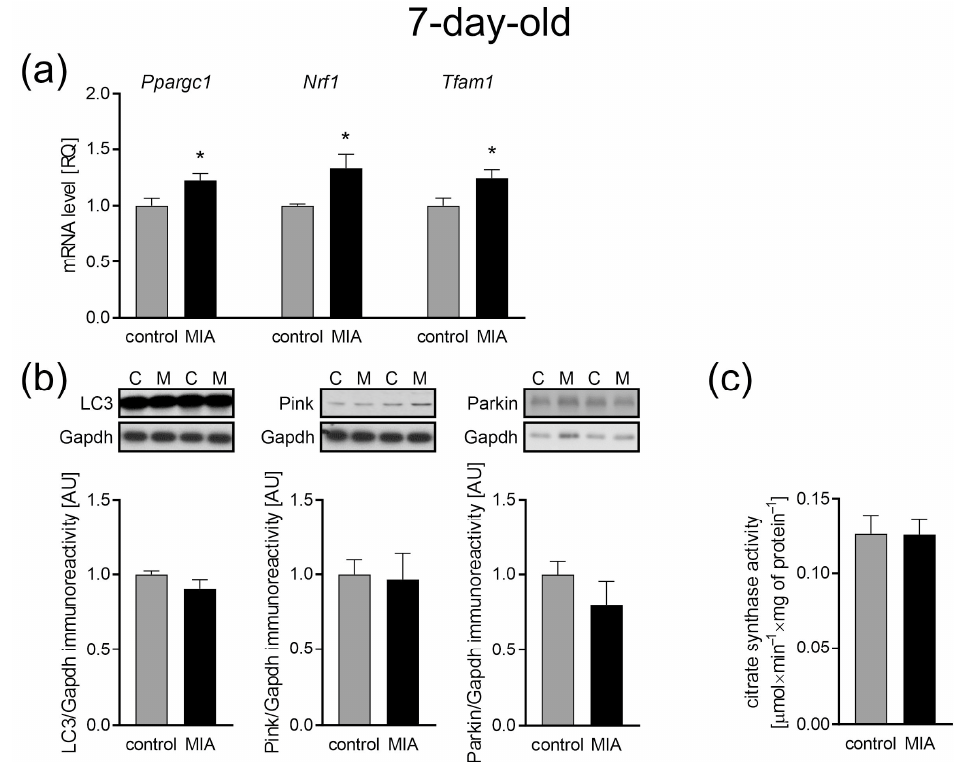
Figure 6. The effect of MIA on the mitochondria content, biogenesis, and autophagy processes in the brain of a 7-day-old MIA offspring rats. ( a ) The level of mRNA for the main biogenesis genes, Ppargc1 (n = 5 and 6), Nrf1 (n = 4 and 6), and Tfam1 (n = 5 and 6) was measured by real-time PCR and with Actb as a reference gene. ( b ) The level of immunoreactivity of LC3 (n = 7), Pink (n = 7), and Parkin (n = 5 and 4) was analyzed using the Western blot method. Densitometric analysis was performed using normalization to the immunoreactivity of Gapdh. Representative immunoblots are presented. ( c ) The mitochondria content was measured by the activity of the citrate synthase (n = 8). Data represent the mean value ± S.E.M. and were analyzed using Student’s t -test, * p < 0.05 compared with the control group.